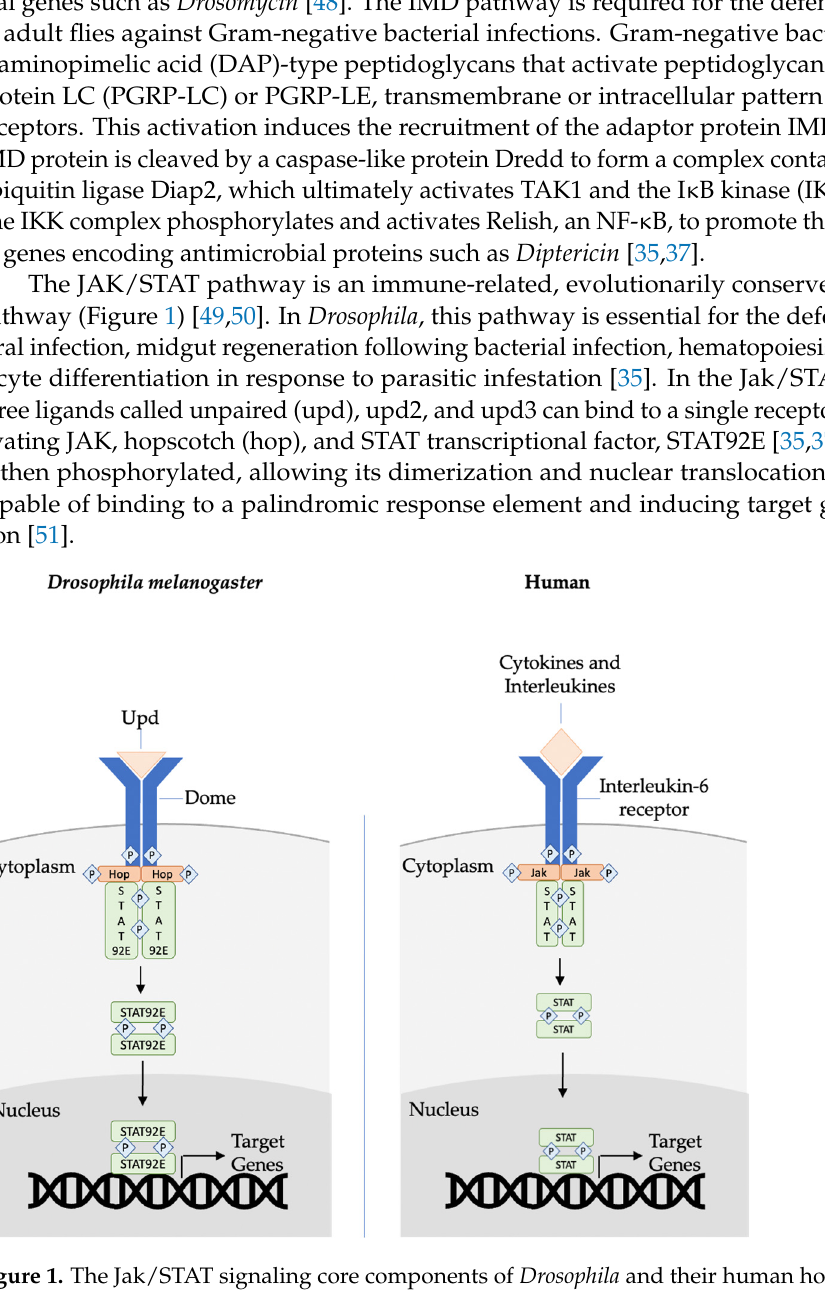
Figure 1. The Jak/STAT signaling core components of Drosophila and their human homologs. Upd (Interleukin or cytokine in humans) binds to its signaling receptor Dome (interleukin-6 receptor in humans), activating the associated Hop (Jak1, 2, 3, tyrosine kinase 2 in humans), and initiating a cascade of actions. Activated Jak phosphorylates other Jaks and the receptor, thereby forming a STAT protein-binding site. The phospho-STATs undergo dimerization and nuclear translocation. The STAT DNA-binding domain identifies promoter and enhancer regions of target genes, hence activating their